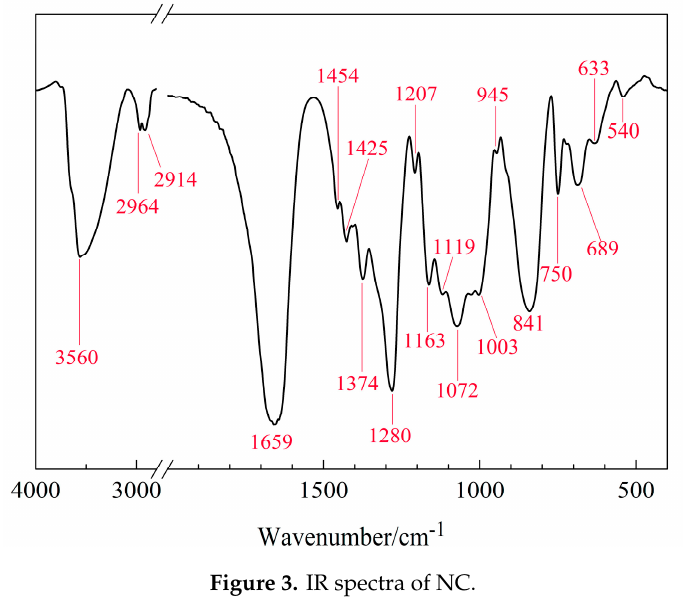
Figure 3. IR spectra of NC. Coatings 2020 , 10 , x FOR PEER REVIEW